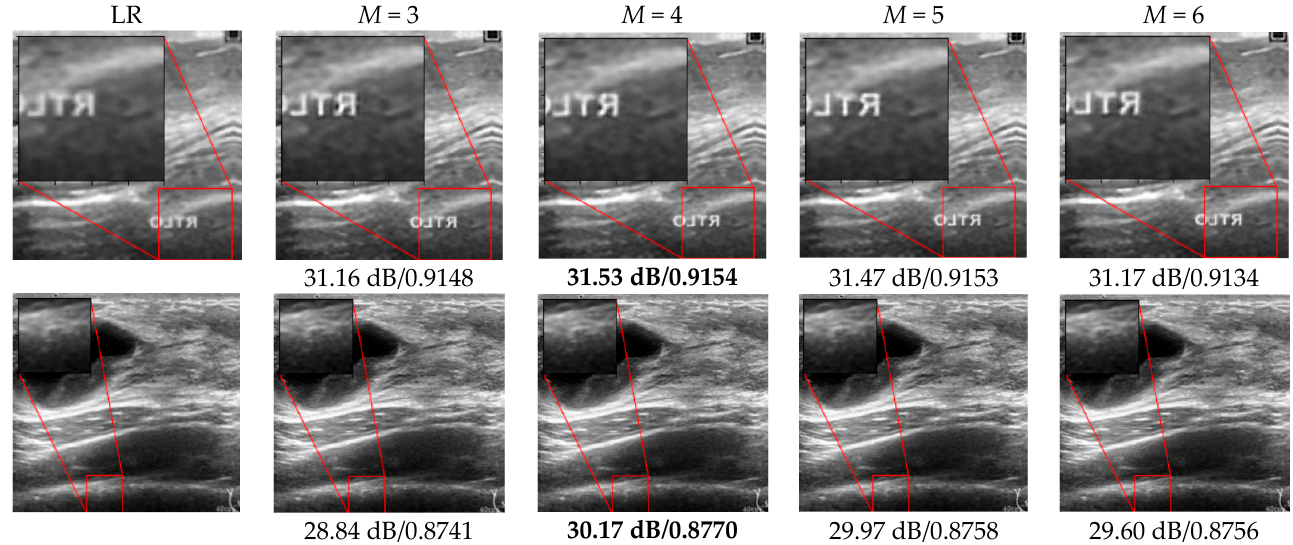
Figure 8. SR results produced by the FEN with variable network depths for Dataset A (top row), and Dataset B (bottom row). PSNR and SSIM values are shown below each sub-figure. Top row (Dataset A), and bottom row (Dataset B). Bold numbers represent the highest values of PSNR and SSIM.